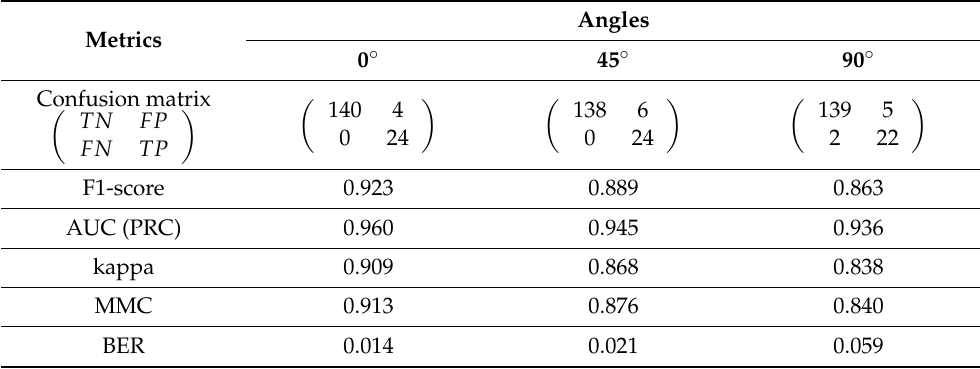
Table 3. Statistical results for the IRT data of the group of 12 participants for three angles between the longitudinal axis of the body and the cameras. Angles Metrics 0 ◦ 45 ◦